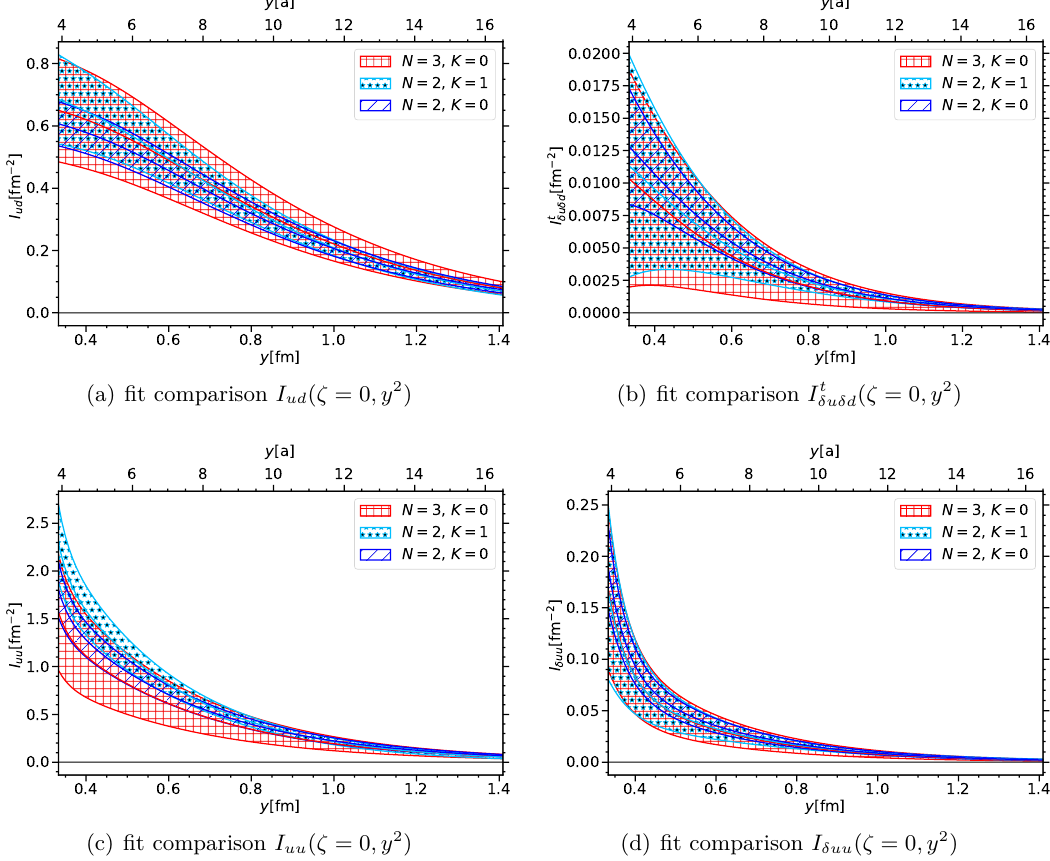
Figure 19 . Results for selected DPD Mellin moments, where we compare the curves obtained from the fits with ( N, K ) = (2 , 0) , (2 , 1) , (3 , 0)